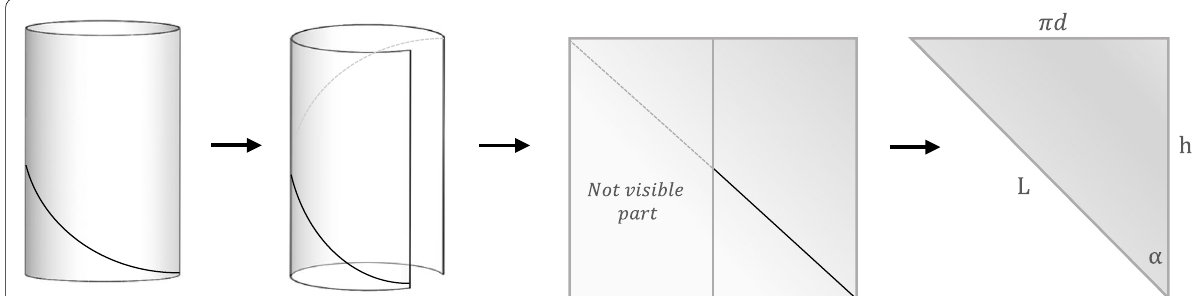
Fig. 1 Geometric relations for a helical